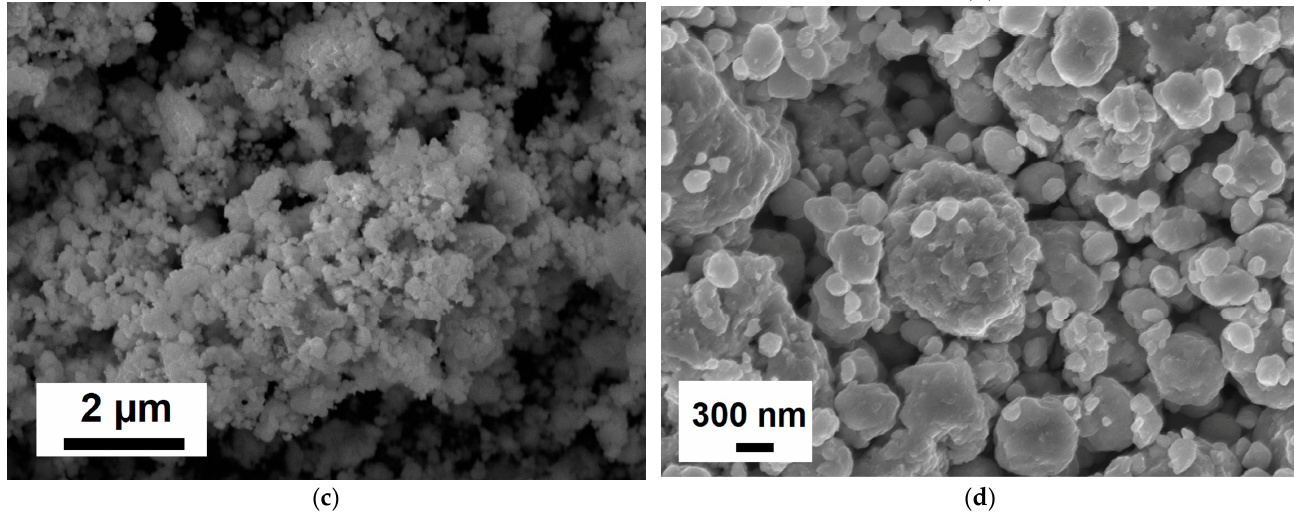
Figure 2. General view of the initial niobium powder ( a ) and composite granules “Nb + 7% mass ND” after various treatment periods of mechanical alloying: ( b ) 0.5 h; ( c ) 1.2 h; ( d ) 6 h (( a – c ) SEM TESCAN VEGA3; ( d ) SEM Supra 50VP).